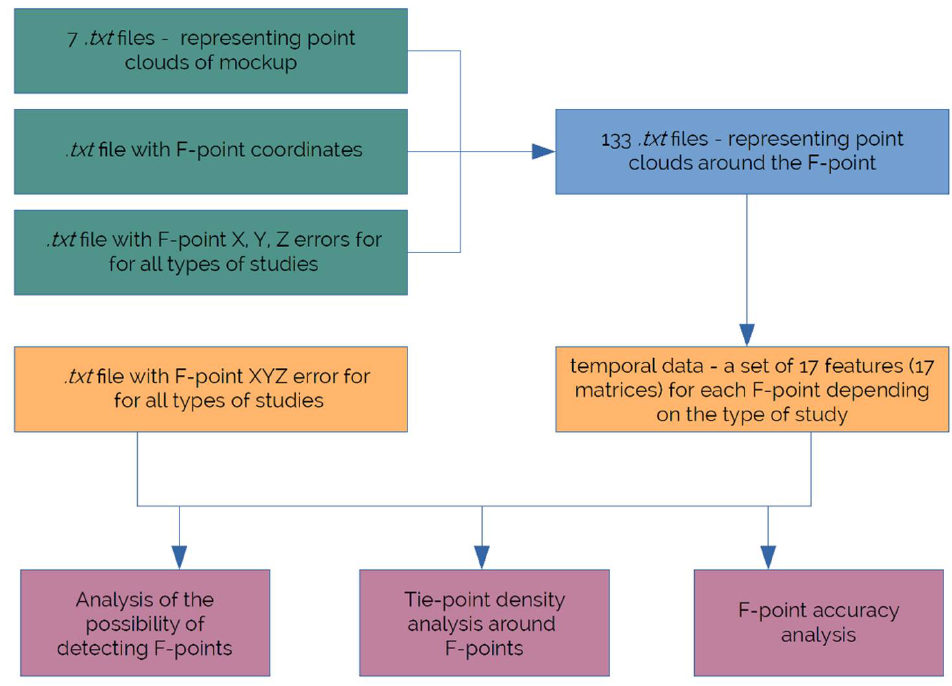
Figure 1. Principles of procedure during the point clouds’ analysis.